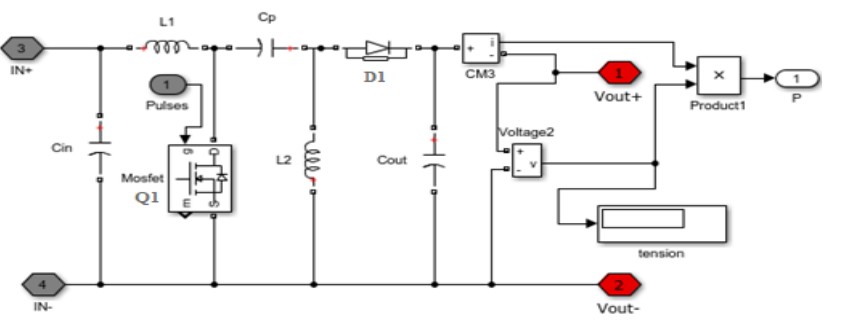
Figure 4. Simulink model of the SEPIC converter. Table 1. Values of the main components of the SEPIC.